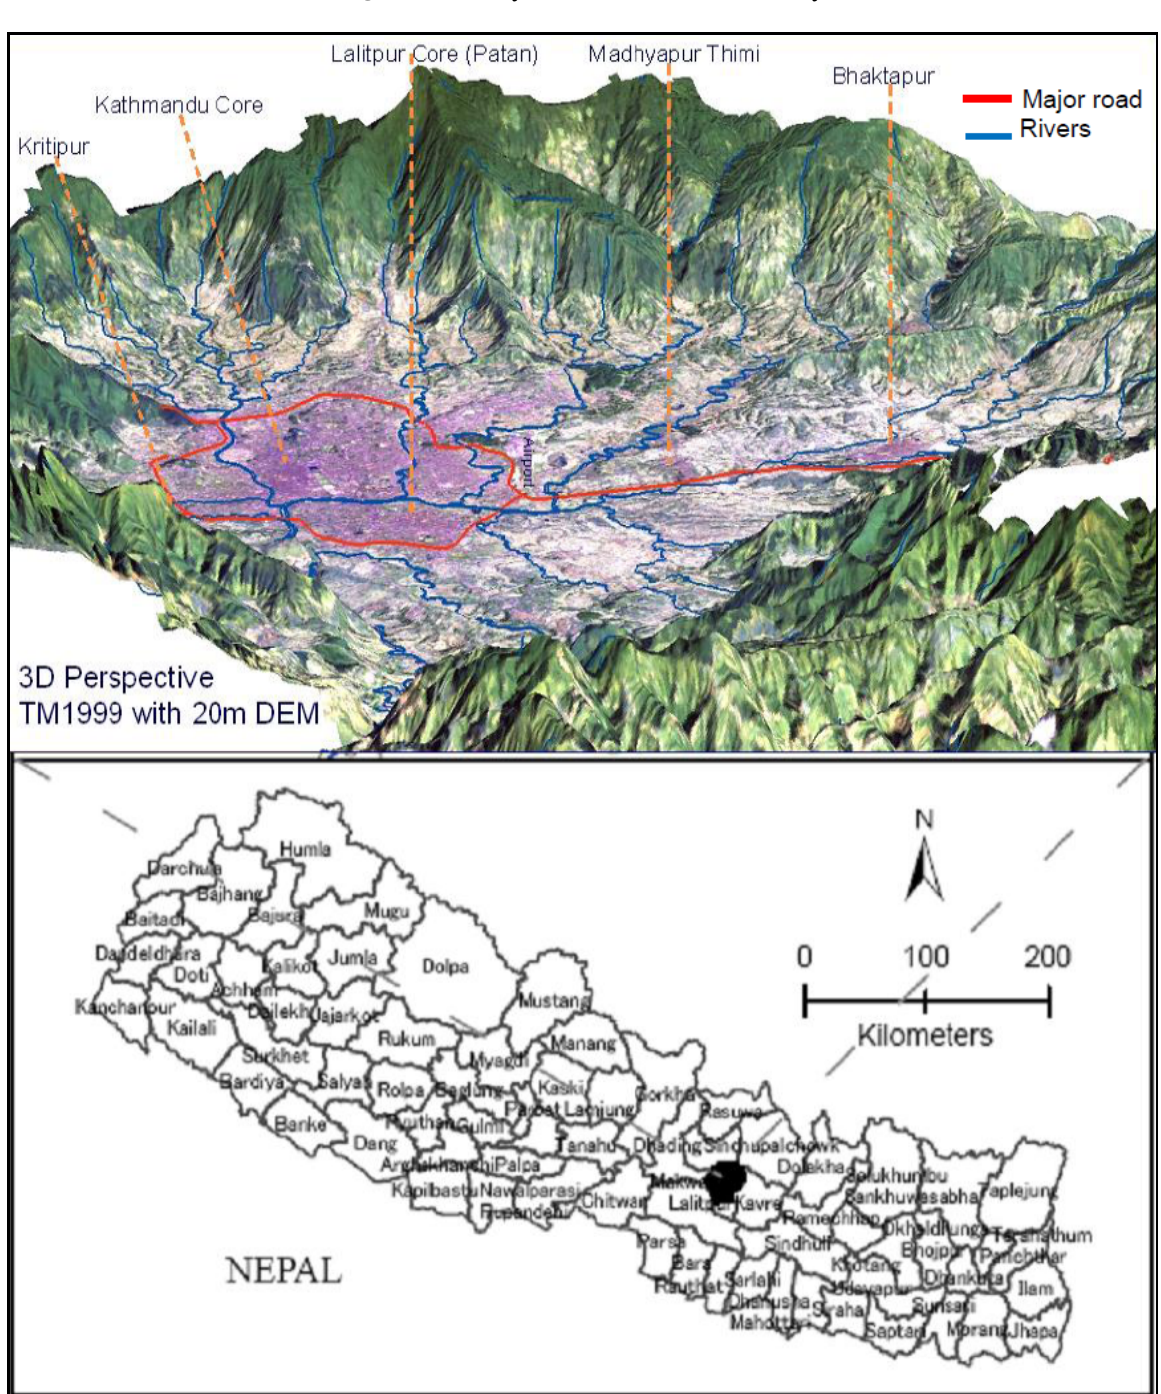
Figure 3. Study area–Kathmandu